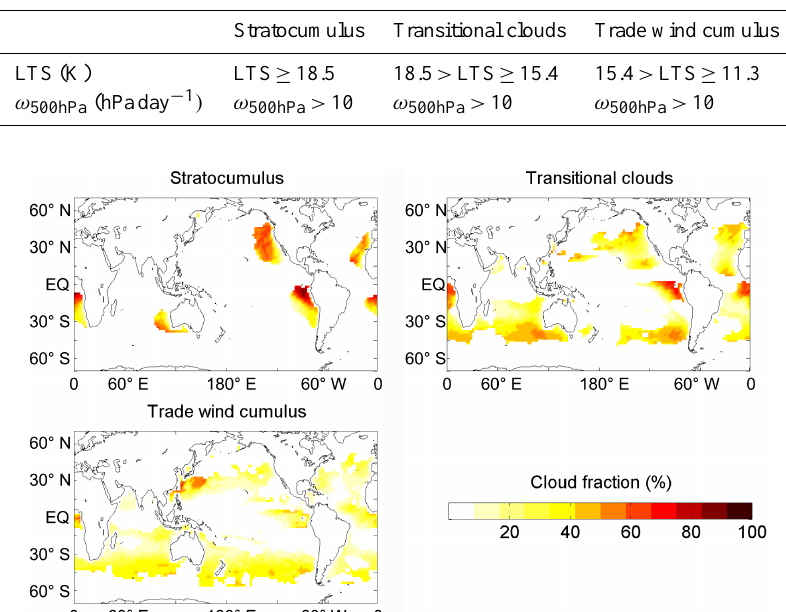
Table 3. Criteria used to conditional sampling stratocumulus, transitional clouds, and trade wind cumulus regimes (adopted from Medeiros and Stevens, 2011).